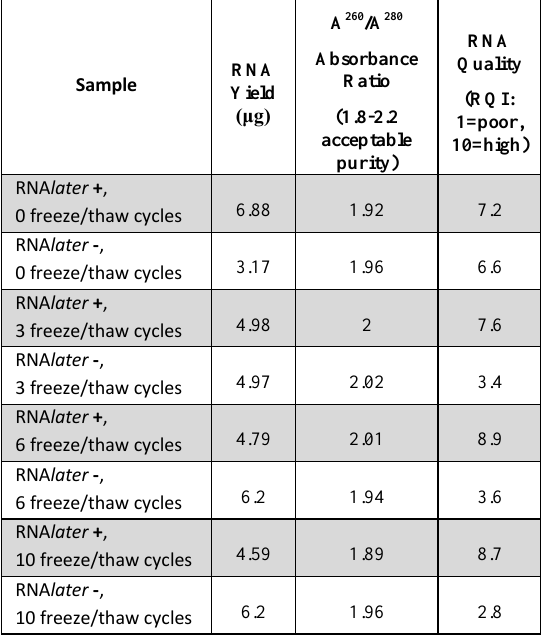
TABLE I: RNA yield, purity and